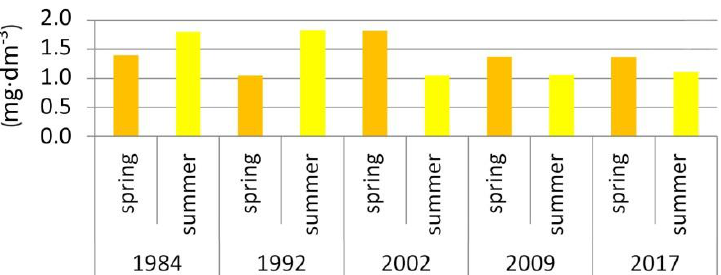
Figure 11. Changes in concentrations of total nitrogen (mg·dm −3 ) in Lake Borówno in 1984 – 2017